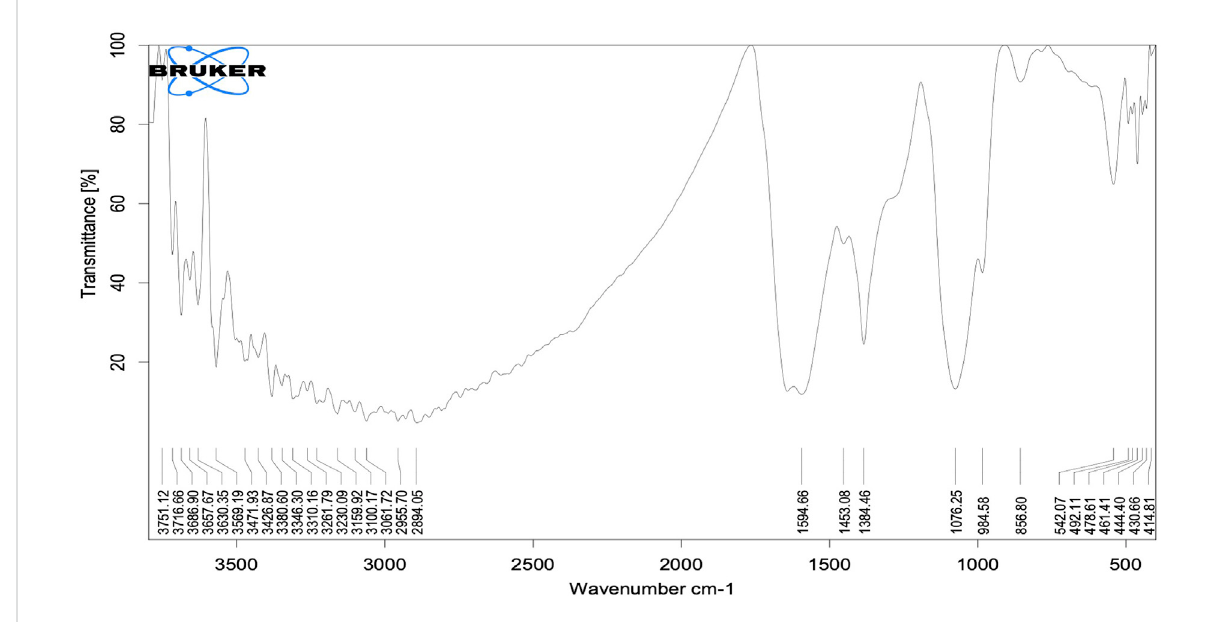
FIGURE 3 FTIR spectra of synthesized AgNPs.